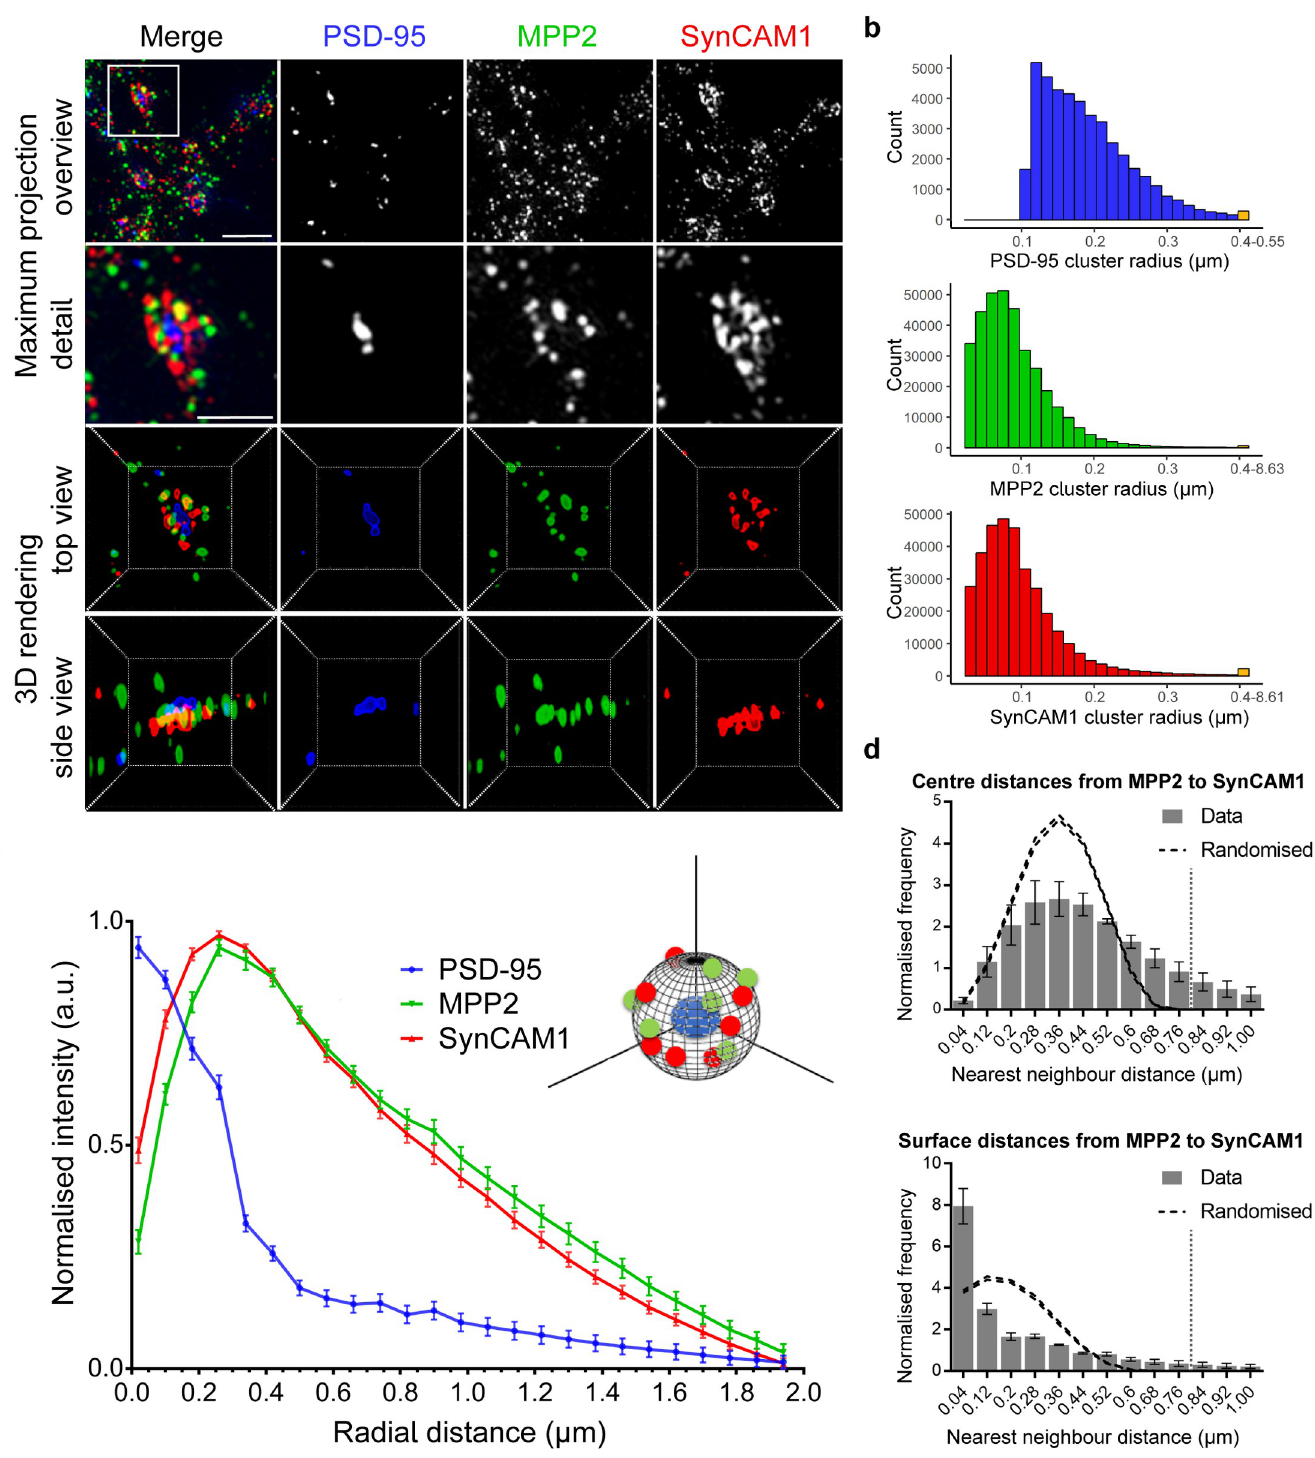
Fig 2. Clusters of MPP2 and SynCAM 1 form bracelet-like arrangements at the edge of the PSD. Mature (DIV21) primary rat hippocampal neurons immunostained for endogenous PSD-95 (blue, second column), MPP2 (green, third column), and SynCAM 1 (red, fourth column) and subjected to 3D SIM. (a) More than 90% of the imaged dendritic spines express all 3 proteins of interest (overview maximum projection, first row). A single synapse detail (second row) depicts the bracelet-like arrangements of MPP2 and SynCAM 1 surrounding central PSD-95 puncta. A 3D rendering of that particular synapse in top (third row) and side view (fourth row) reveals that SynCAM 1 and MPP2 clusters are arranged in an interlocked, bracelet-like form, surrounding a central cluster of PSD-95. Scale bars: overview 1 μ m; detail